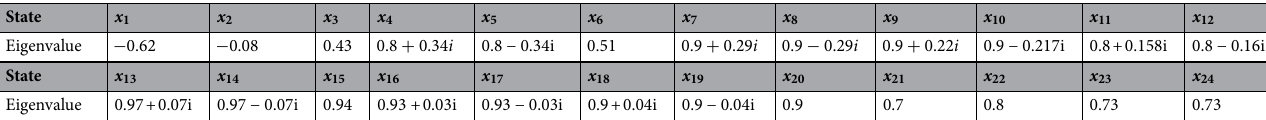
Table 2. The systems’ states and their corresponding closed-loop Eigenvalues.